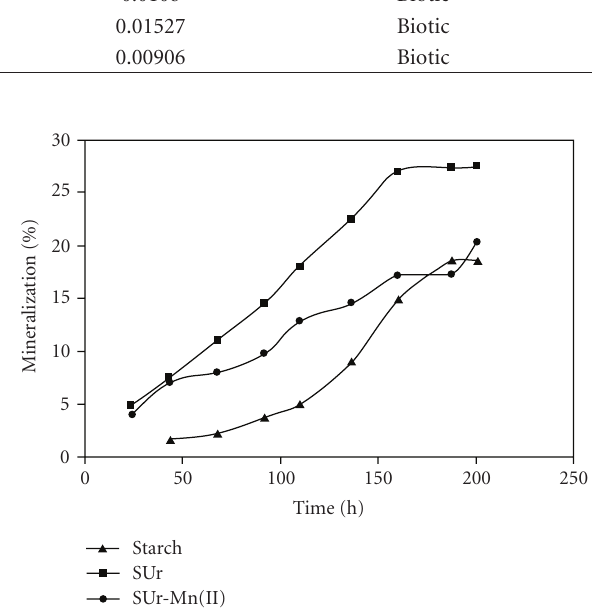
Figure 3: %CO 2 mineralization of starch, SUr and SUr-Mn(II).